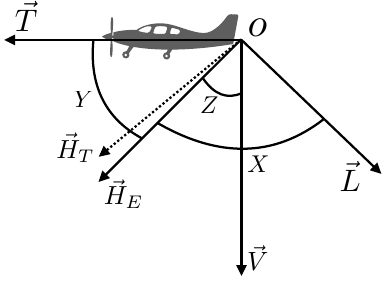
Figure 1. The LTV reference